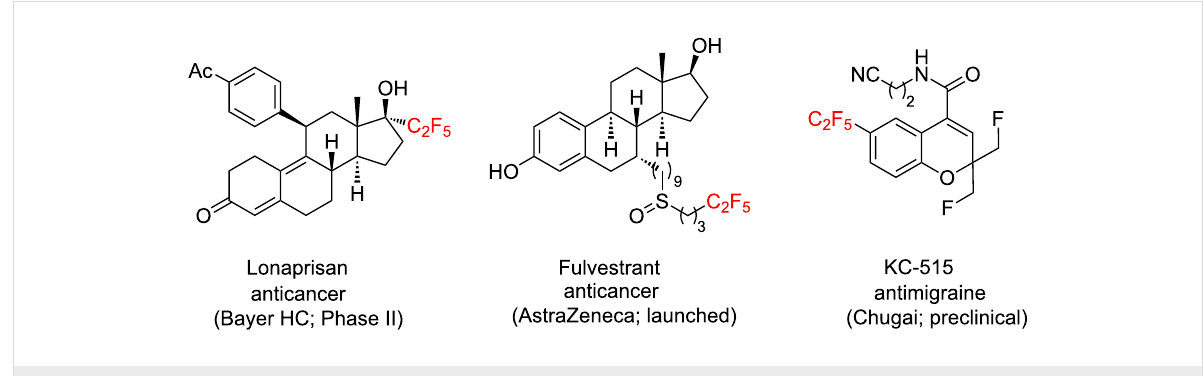
Figure 1: Bioactive compounds and agrochemicals with fluorinated pyrazoles.